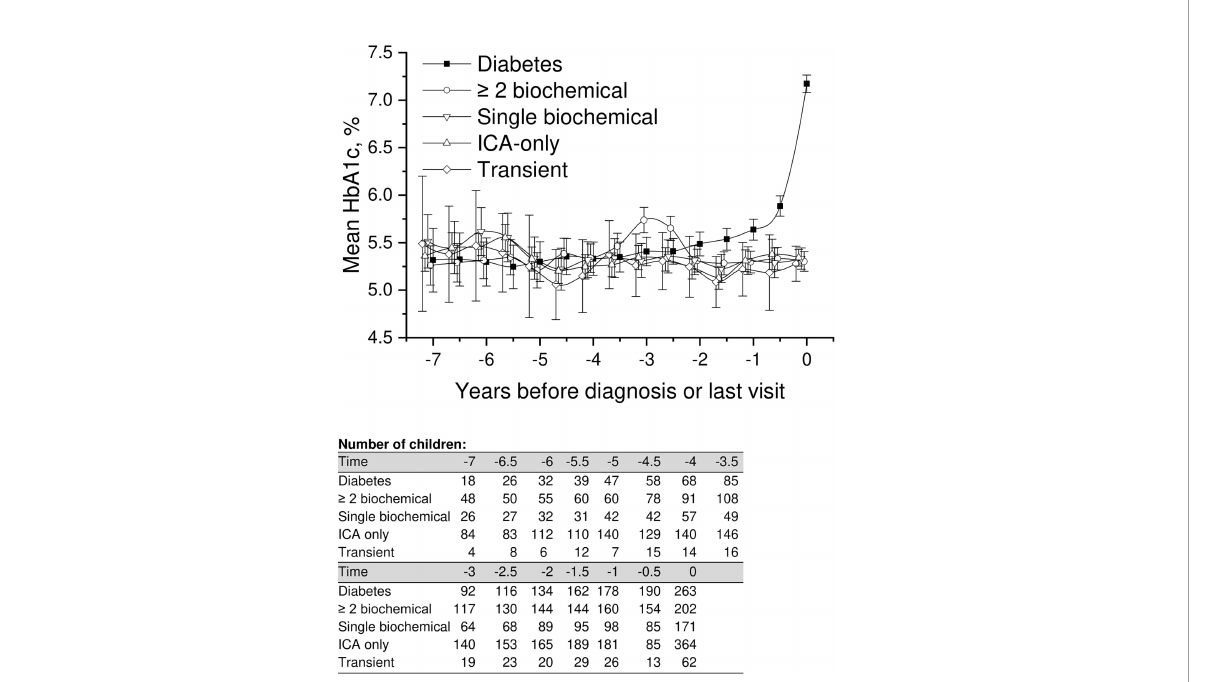
FIGURE 2 Adjusted mean HbA1c, during the follow-up in children divided into fi ve risk groups. The last points are diagnosis of type 1 diabetes (progressors, black squares) or the last follow-up visit by 31 August 2014. Whiskers show 95% con fi dence intervals of the adjusted mean in the linear mixed model. In the early values during 4.5 – 6 years before diagnosis, the progressors showed signi fi cantly lower HbA1c values compared to single biochemical autoantibody and low-risk groups. Toward diagnosis, HbA1c values started to increase in the